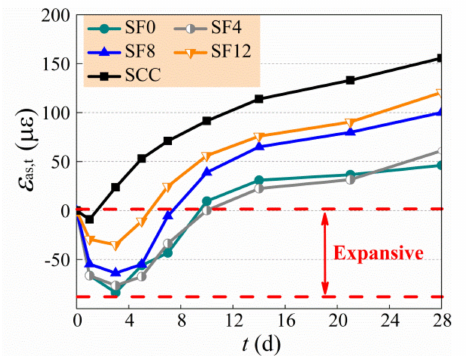
Figure 7. Changes of expansive deformation with the v f .